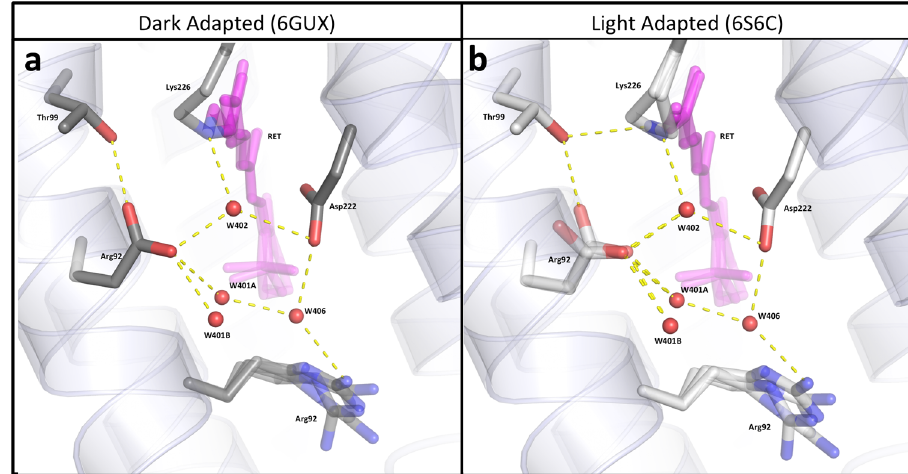
Fig. 4 Structures of the pentagonal H-bond networks in AR3. Predicted H-bonds are represented by yellow dashes (for distances see Supplementary Table 4) for DA ( a ) and LA AR3 ( b ). Selected amino acid sidechains are shown in stick representation with atoms colored using the CPK convention. Water molecules are shown as red spheres and retinal is colored pink. Wat401 is seen in two positions (A and B) at partial occupancy and the sidechain of Arg92 is seen in four conformations for both AR3 structures. Wat402 has single occupancy in AR3 (b) and bR (Wat602 in Supplementary Fig. 8b) in the LA